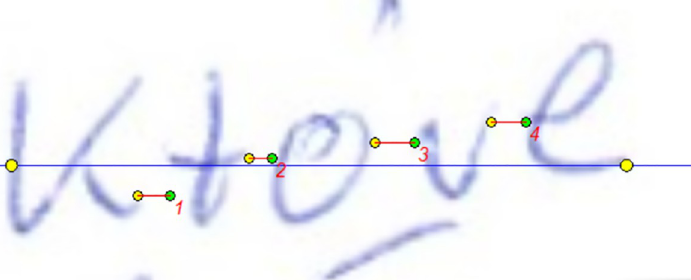
Fig 3. The example of examination with the use of Raygraf software. Estimation of the total width of the specimen (a line between extreme yellow points) and widths of the inter-letter spaces (lines no 1, 2, 3,